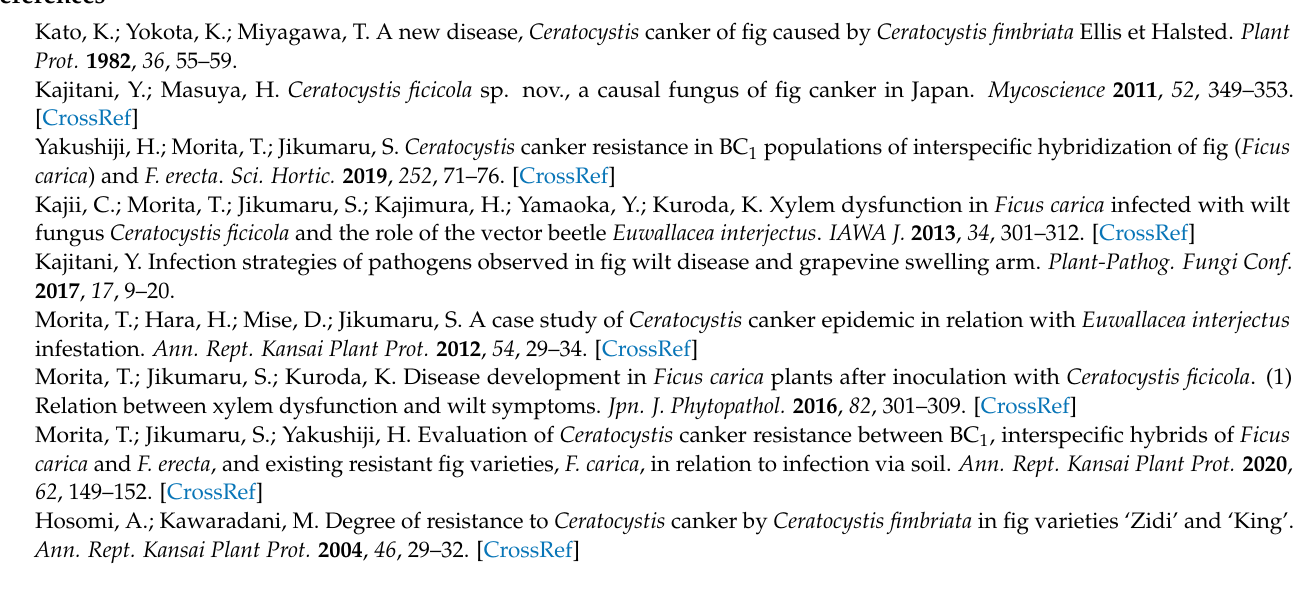
fig saplings that absorbed the acid fuchsin solution. Examples of T3-08 and T4-01 (Dead), T1-01 and Figure S4: Typical examples (i.e., 5a, 5b, 5c, 5d, 5e, and 5f in Figure S3) of pink areas dyed with acid fuchsin solution and brown discoloration on cross stem sections 5 cm above the inoculation site. SAC: Xylem sap-conduction area; DIS: Xylem discoloration area; Dotted line and arrow: Inoculation site and insert direction. Figure S5: Curve fitting of the re-isolation rate of Fusarium kuroshium in T1 and Neocosmospora metavorans in T2. F. kuroshium : y = 3.2235 e 0.0758 x , R 2 = 0.878, p = 0.005 < 0.01;